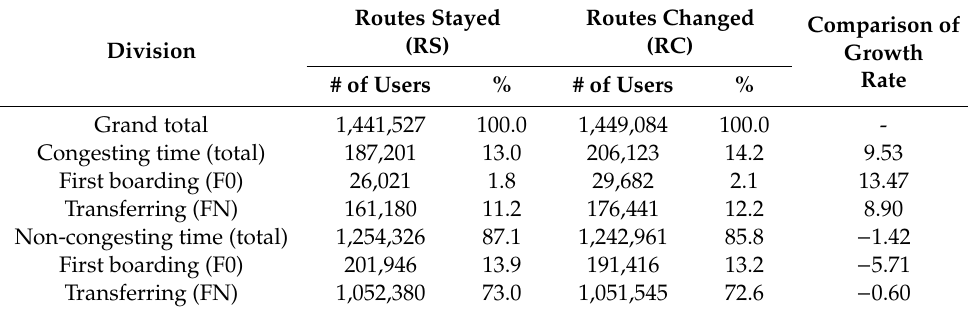
Table 10. Hybrid model for tra ffi c condition and number of